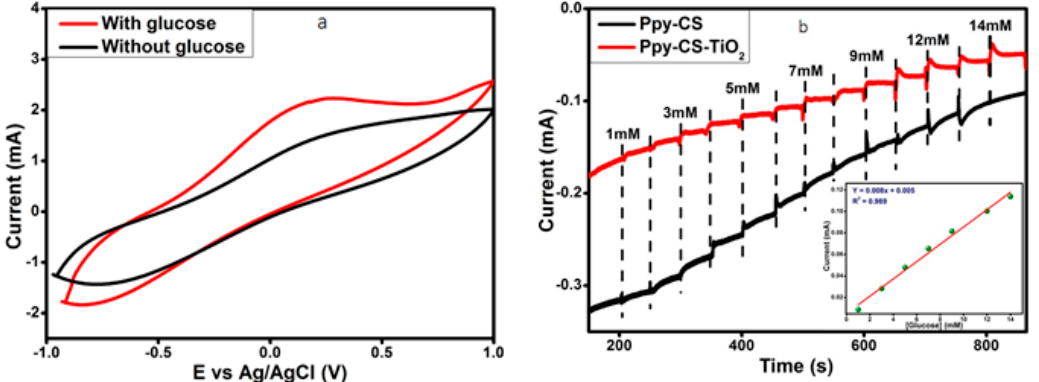
Figure 3. ( a ) CV responses of Ppy-CS-TiO 2 /ITO in 0.1 M NaOH electrolyte with 1 mM glucose and without glucose at the scan rate of 50 mV·s − 1 . ( b ) Amperometric responses to the successive addition of glucose concentration in 0.1 M NaOH solution at +0.13 V (vs. Ag/AgCl). The inset shows the steady-state calibration curve for the of Ppy-CS-TiO 2 nanocomposite/ITO electrode.